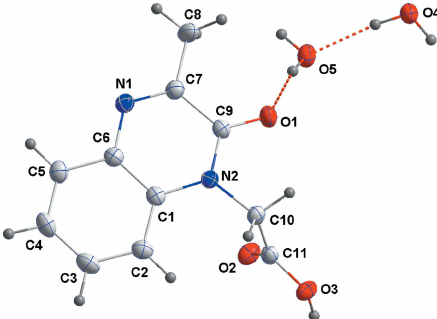
Figure 1 The asymmetric unit of the title compound with labelling scheme and 50% probability ellipsoids. The O—H (cid:2)(cid:2)(cid:2) O hydrogen bonds (Table 1) involving the lattice water molecules are shown as dashed lines. In the crystal, the main molecule, together with the lattice water molecules, form zigzag chains along the b- axis direction